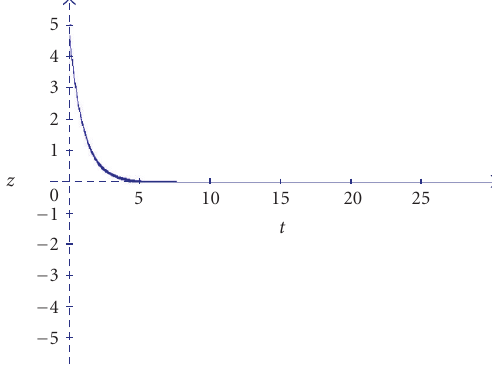
Figure 6.11 . Stable solution of (5.2) in the point L 1 (88,85), a 0 =